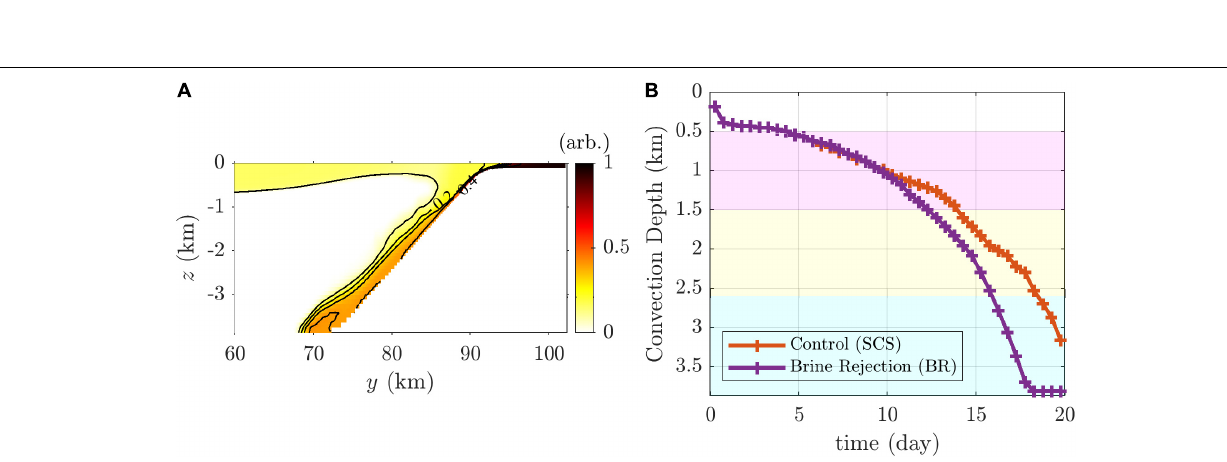
FIGURE 14 | (A) Meridional sections of zonally averaged tracer concentration on day 20 in the BR experiment. (B) Comparison of the convection depths of the convective-plume heads with time in the SCS and BR experiments.